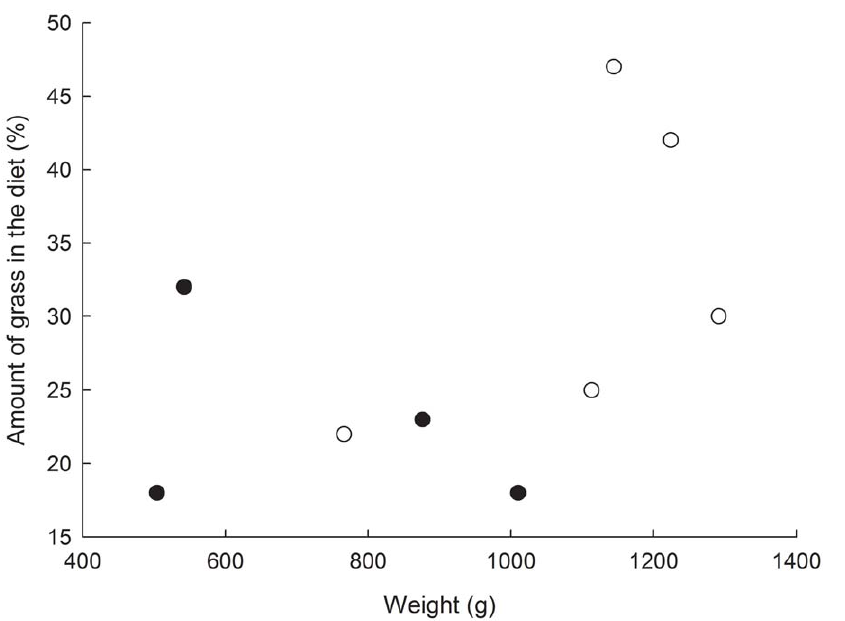
Figure 5. The percentage of grass in the diet as calculated by SIAR in relation to body mass and sex in B.suillus . Females are represented by filled black circles and males by open white circles.